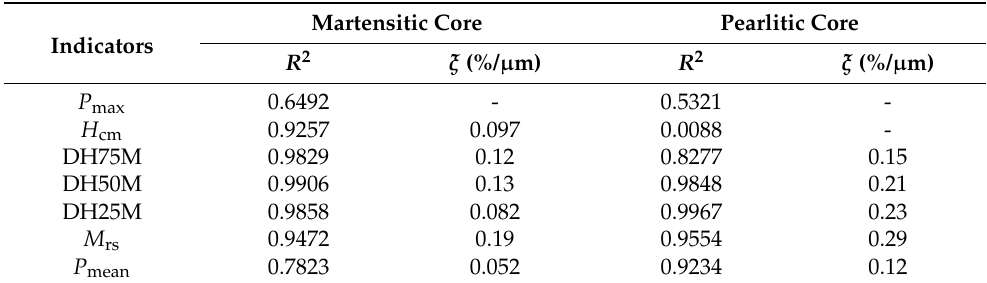
Table 5. Correlation coefficient and normalized sensitivity per depth of features extracted from the typically measured MBN profiles.